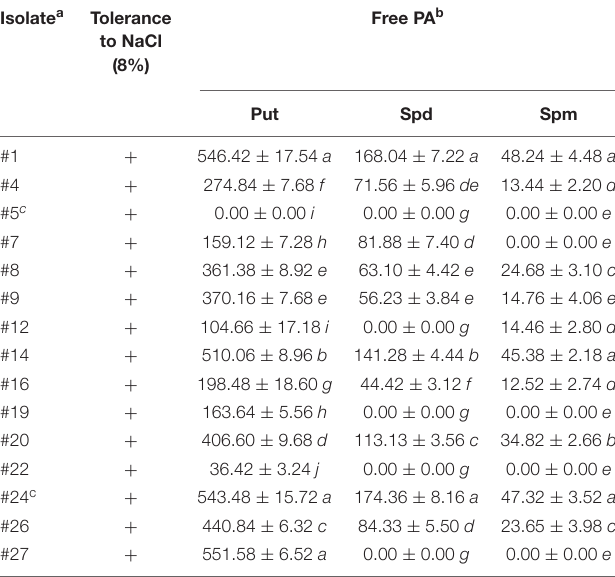
TABLE 1 | In vitro production of the free PAs by selected halotolerant endophytic actinobacterial isolates.